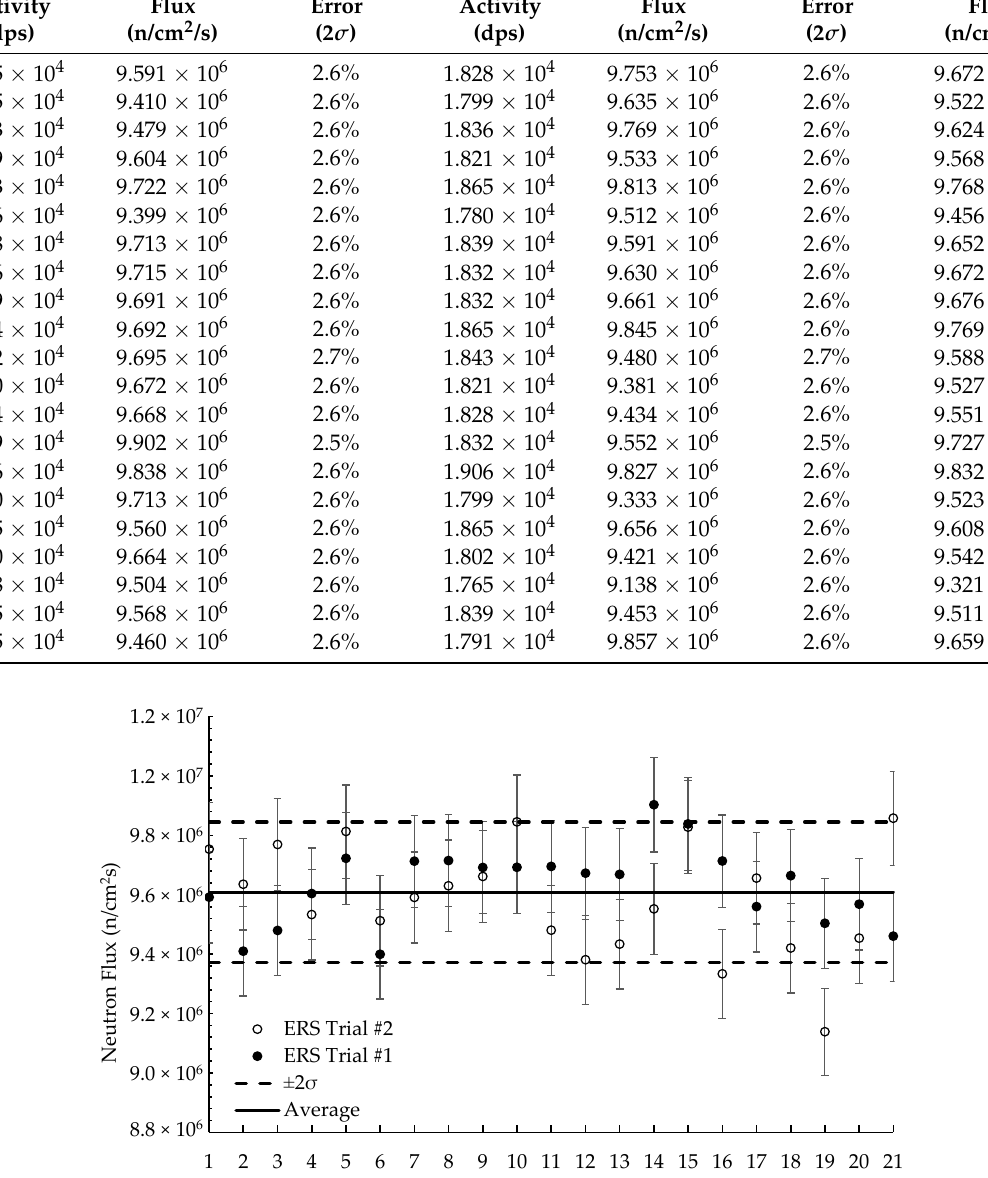
Table 6. Cadmium covered gold foil activity measurements (ERS).